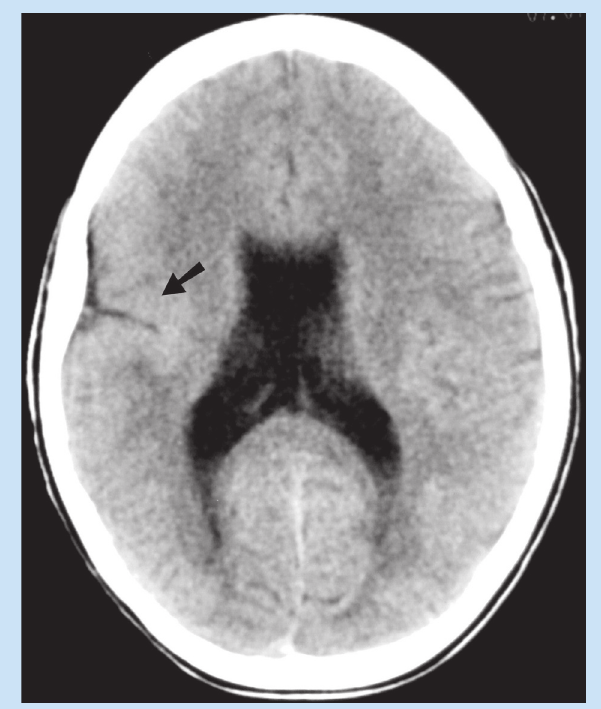
Fig. 1c. Hydranencephaly: there is very little cortical tissue that remains other than the central nuclei and posterior fossa structures after a severe in utero